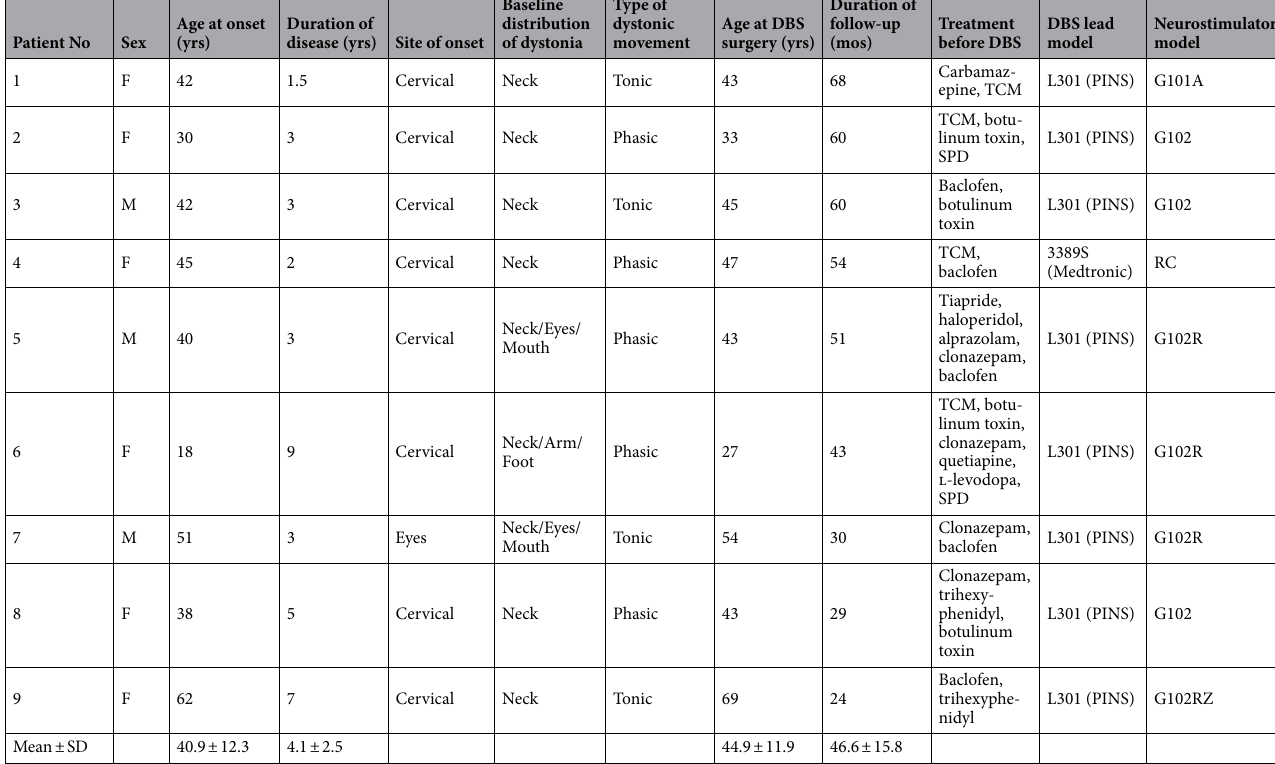
Table 1. Clinical characteristics and DBS devices model for each patient with isolated cervical dystonia. DBS deep brain stimulation, F female, M male, SPD selective peripheral denervation, TCM traditional Chinese medicine, SD standard deviation, yrs years, mos